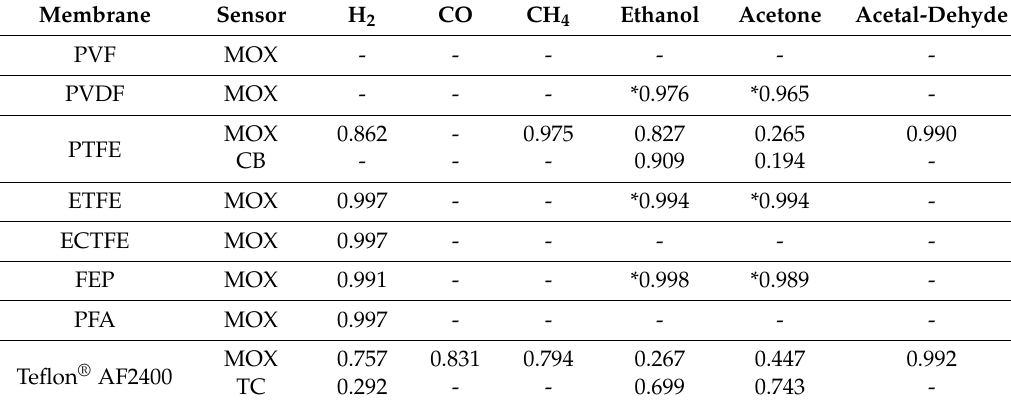
Table 3. Retention capacities of the PVF, PVDF, PTFE, ETFE, ECTFE, FEP, PFA and Teflon ® AF2400 membranes. The values given are the arithmetic mean of three measurements. For some retention capacities (*), the maximum is reached after ≥ 20